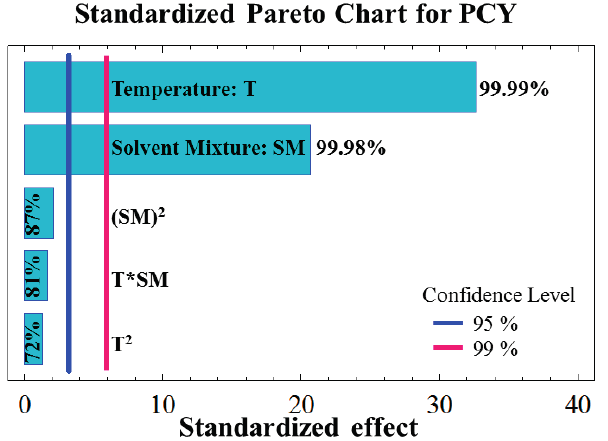
Figure 1. Standardized Pareto charts for phenolic compound yields (PCY); vertical bars blue and red show the confidence level of parameters significance at 95% and 99%, respectively.